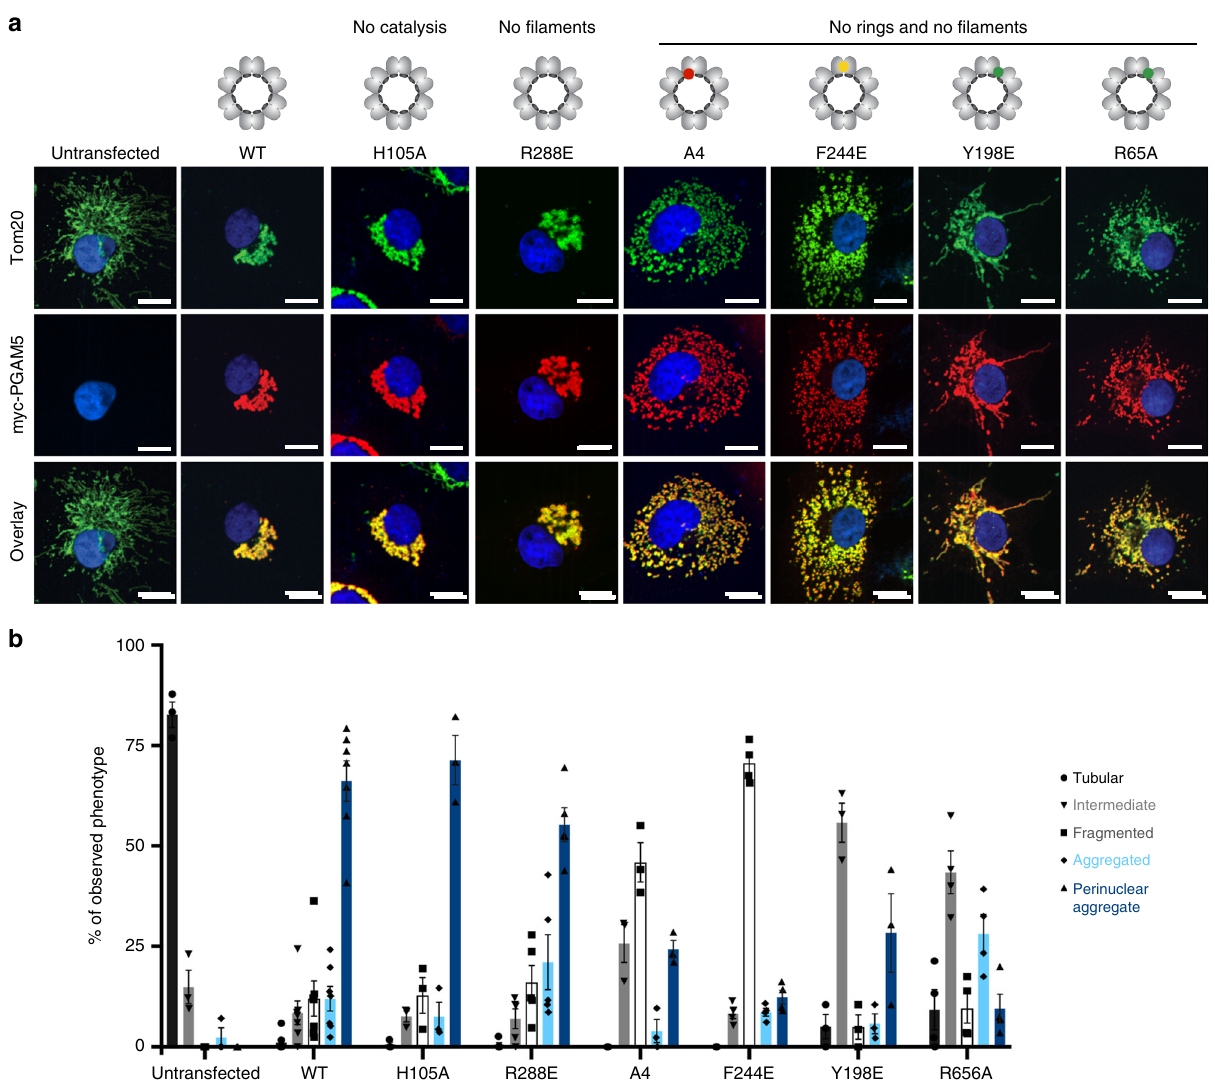
Fig. 7 Multimerization of full-length PGAM5 promotes clustered mitochondrial morphology. a Representative confocal images of COS7 cells transiently transfected with the wild type (WT) or mutant full-length myc-tagged PGAM5 constructs and immunostained for the OMM marker Tom20 with anti- Tom20 antibody (green), PGAM5 with anti-myc antibody (red), and nucleic-stain DAPI (blue). All scale bars correspond to 15 µ m. b Quanti fi cation of mitochondrial phenotypes observed by confocal microscopy in COS7 cells transiently expressing PGAM5 variants as described in a , based on at least three independent experiments per construct. Data are represented as mean ± S.E.M., determined using GraphPad Prism. Untransfected cells: n = 122 cells over three experimental replicates. Cells expressing PGAM5 WT: n = 296 cells over seven experimental replicates. Cells expressing PGAM5 H105A: n = 141 cells over three experimental replicates. Cells expressing PGAM5 R288E: n = 212 cells over fi ve experimental replicates. Cells expressing PGAM5 A4: n = 144 cells over three experimental replicates. Cells expressing PGAM5 F244E: n = 186 cells over four experimental replicates. Cells expressing PGAM5 Y198E: n = 108 cells over three experimental replicates. Cells expressing PGAM5 R65A: n = 141 cells over four experimental